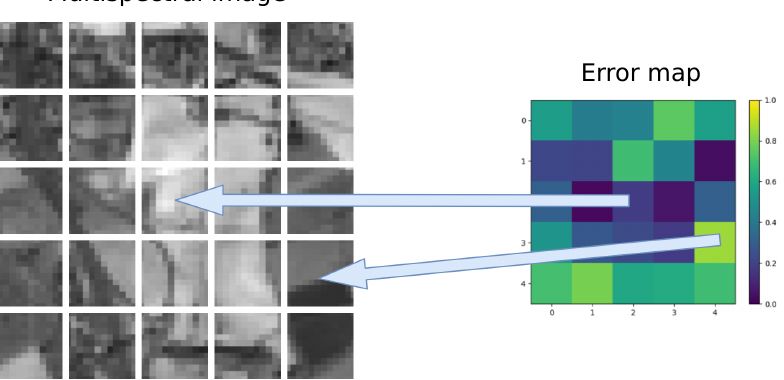
Figure 4. Reconstruction error map measured as Root Mean Square Error (RMSE) in a range of values from 0 to 16,384 obtained by the discriminator of the